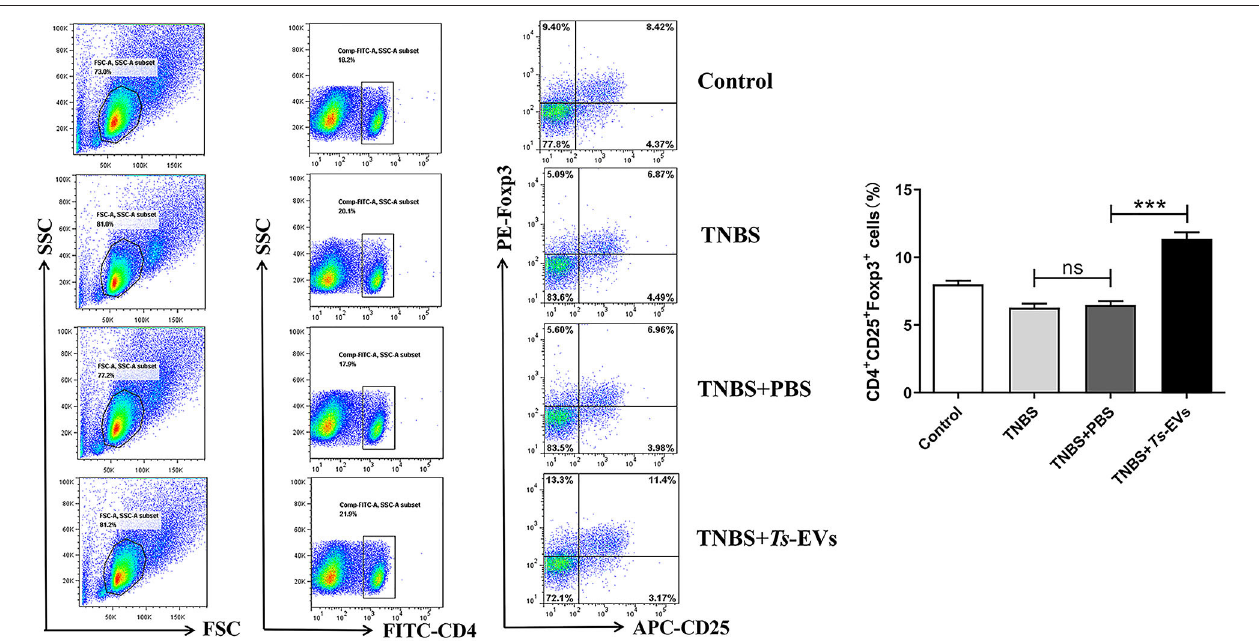
FIGURE 8 | Flow cytometry analysis of Treg cells in the MLNs of mice with TNBS-induced colitis pretreated or not with Ts -EVs. The percentages of CD4 + CD25 + Foxp3 + Treg cells are shown. Results are shown as mean ± SD of each group ( n = 3). Statistical analysis was performed with one-way ANOVA followed by Tukey’s multiple-comparison test. *** p <